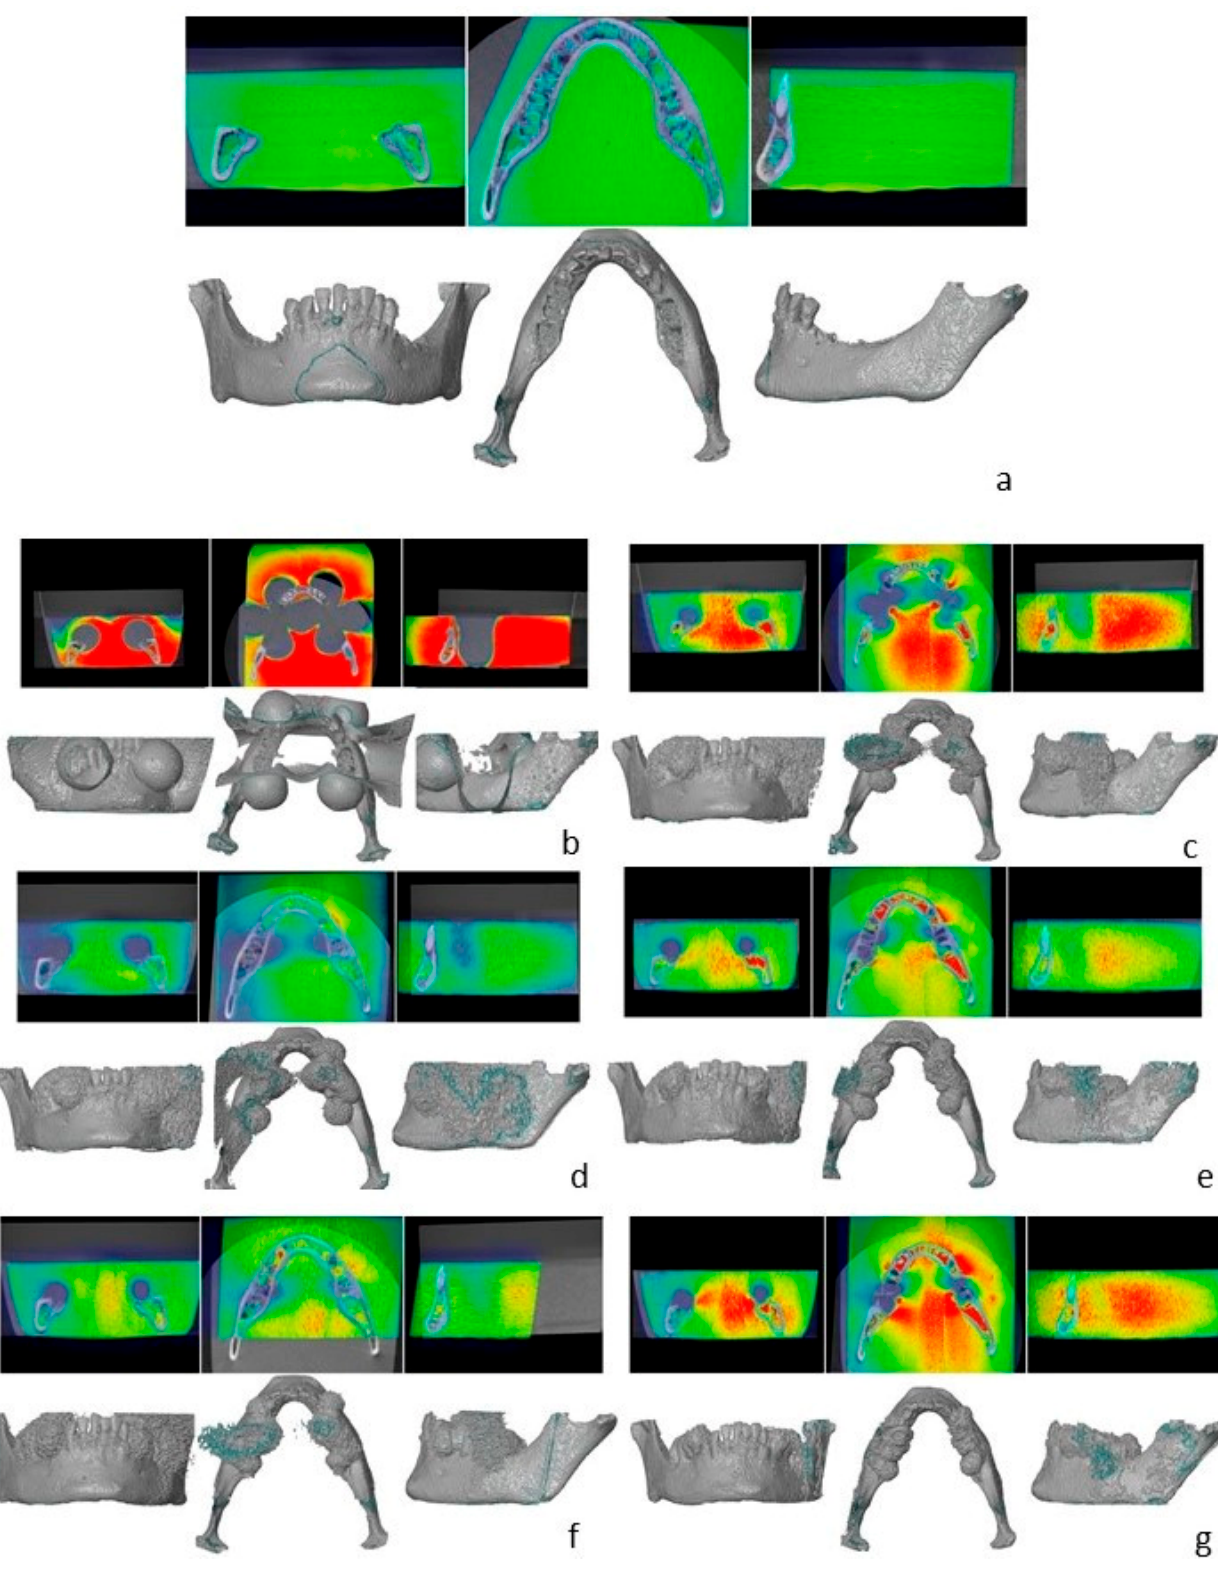
Figure 4. Overview of three-dimensional reconstruction in coronal, axial, and sagittal overviews. ( a ) Reference dataset. ( b ) no SEMAC. ( c ) SEMAC weak. ( d ) SEMAC weak, FID reduction. ( e ) SEMAC moderate. ( f ) SEMAC moderate, transverse direction. ( g ) SEMAC strong.